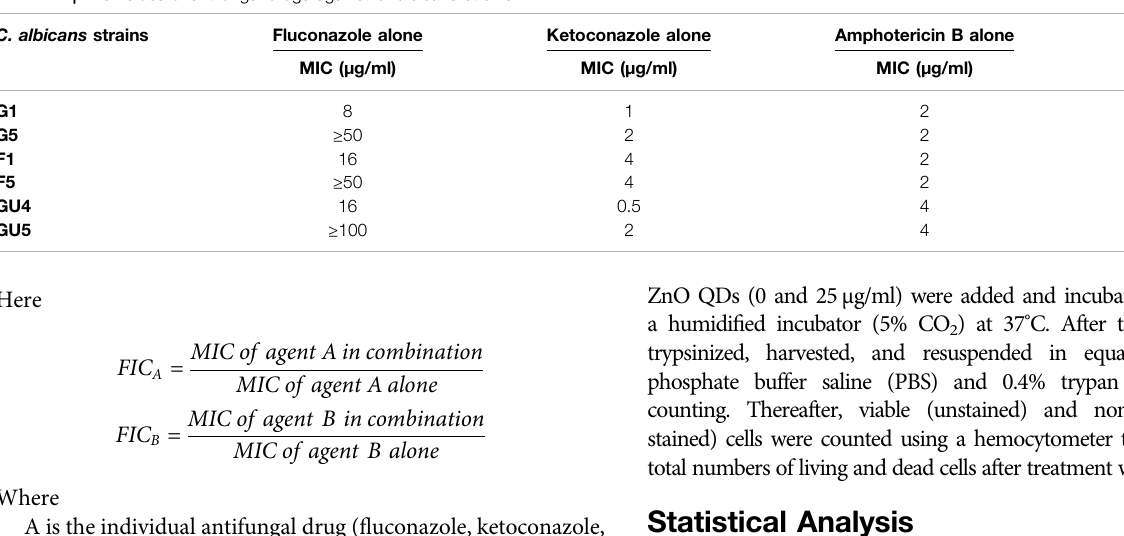
TABLE 2 | MIC values of antifungal drugs against C. albicans